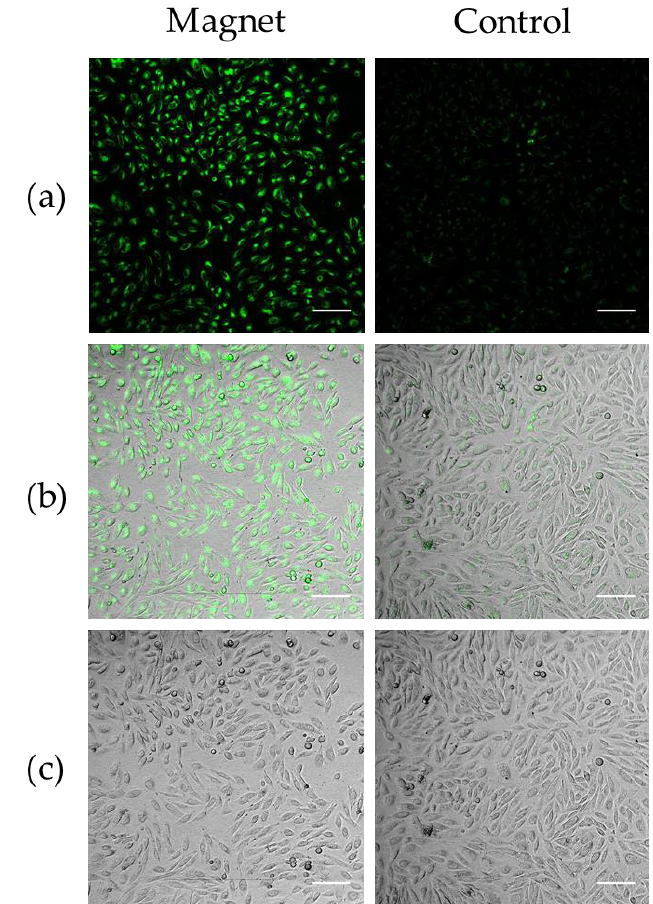
Figure 2. Internalization and coumarin release from Dendr-NP-Coum in the same dish. ( a ): fluorescence emission from coumarin 6( b ): overlay. ( c ): brightfield. Scale bar: 100µm.